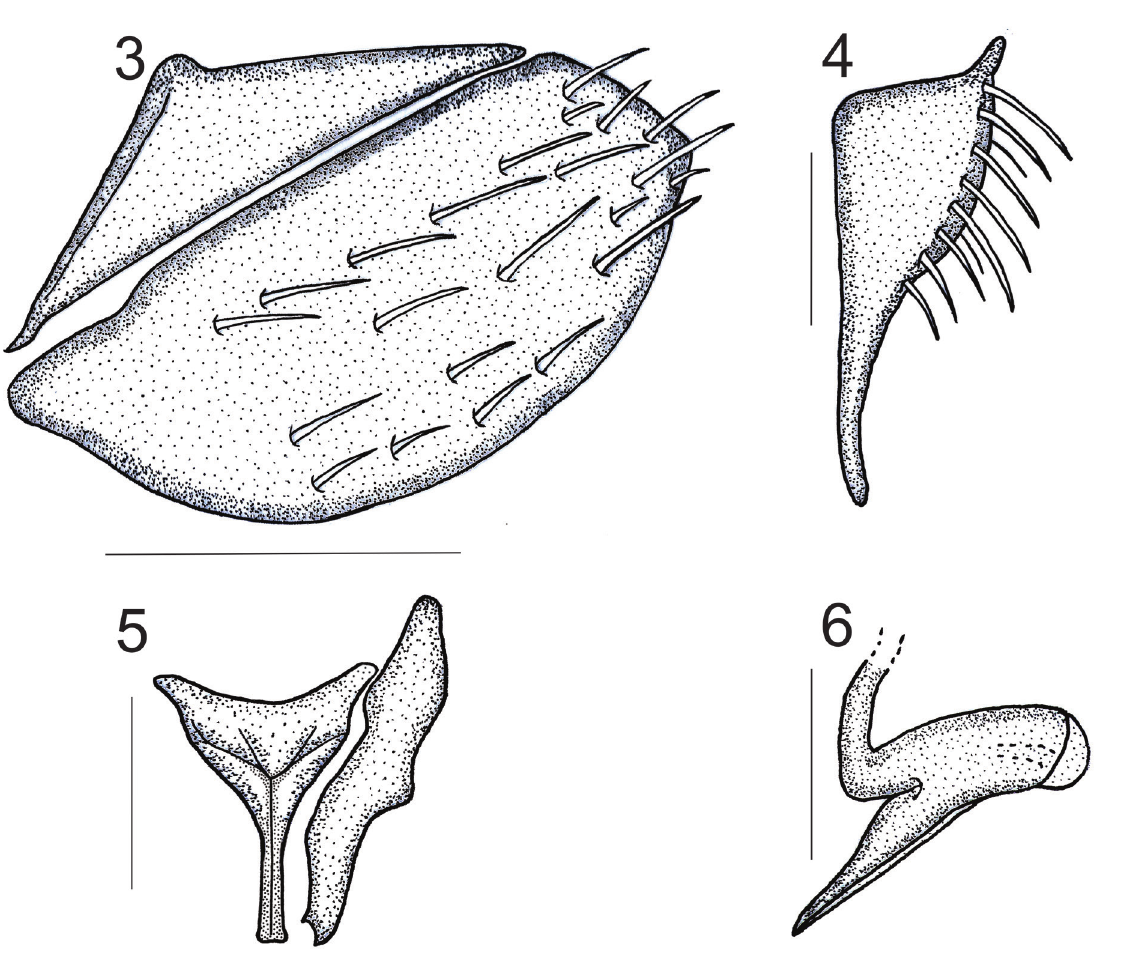
Figs 3–6. Platygonia nigra sp. nov., holotype, ♂ (INPA). 3 . Pygofer, lateral view. 4 . Subgenital plate, ventral view. 5 . Connective and style, dorsal view. 6 . Aedeagus, lateral view. Scale bars: 3 = 0.5 mm; 4–6 = 0.25